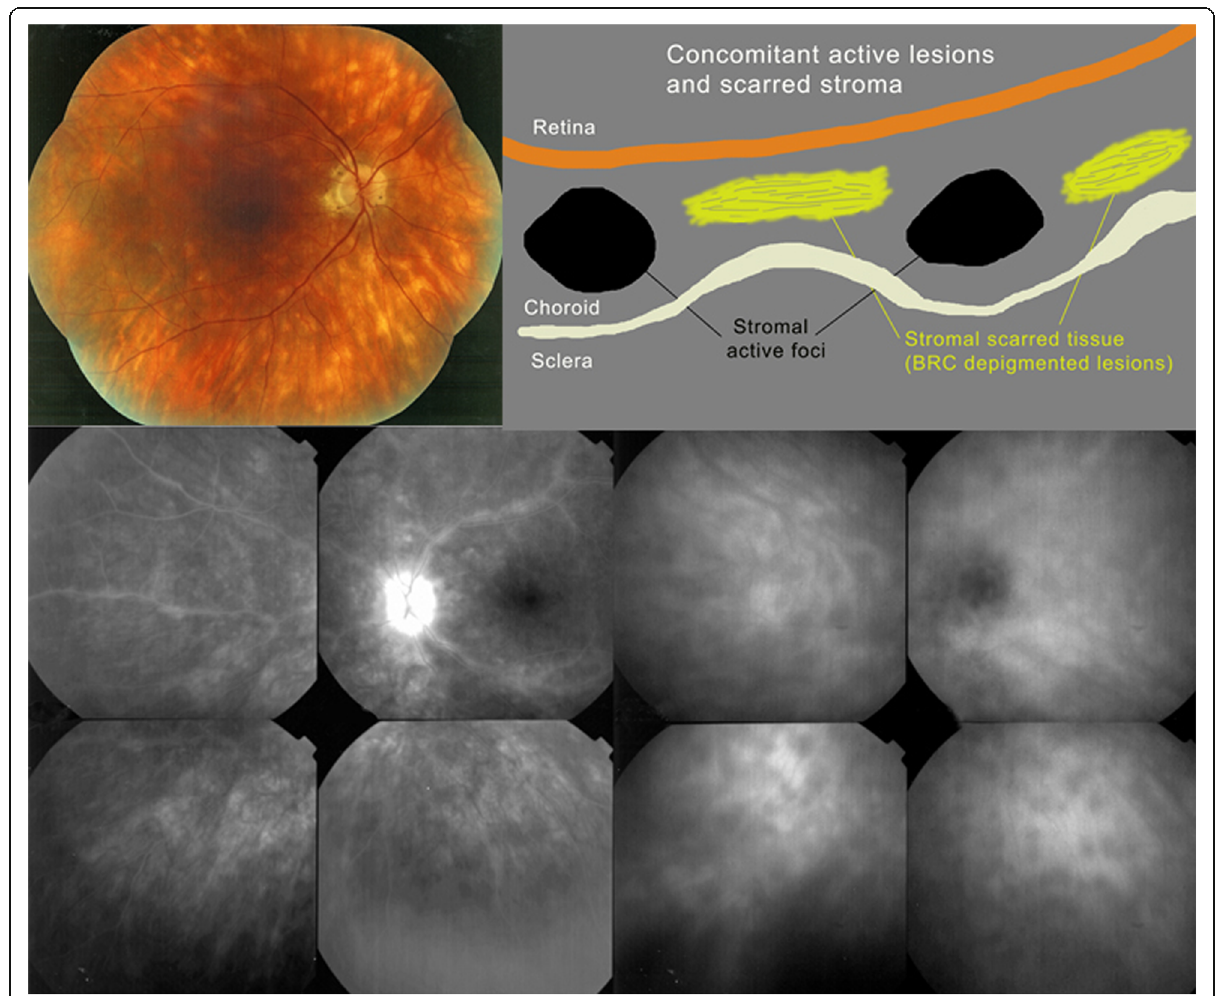
Fig. 19 HLA-A-29 BRC. The typical fundal cream coloured rice shaped lesions are shown on the fundus picture (top left). The marked retinal vasculitis is shown on FA in the left bottom quartet. The choroidal foci are shown on ICGA in the right bottom quartet. The cartoon (inspired by Joan Mirò) (top right) explains that the cream-coloured lesions (yellow) do not correspond to the ICGA HDDs and do not appear on ICGA. HDDs correspond to the black dots on the